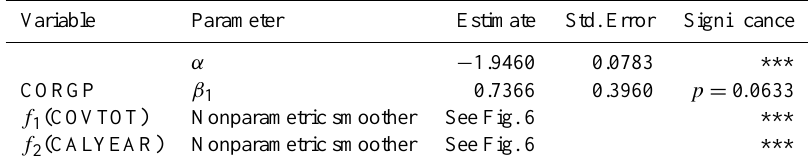
Table 9. Parameter estimates and significances for the model estimating the proportion of grasses (PROPGRASS) as shown in Eq. (13). Significance levels: ***: p < 0.001, **: p < 0.01, *: p < 0.05. The variance of the random effect a in Eq. (13) is 0.1489.